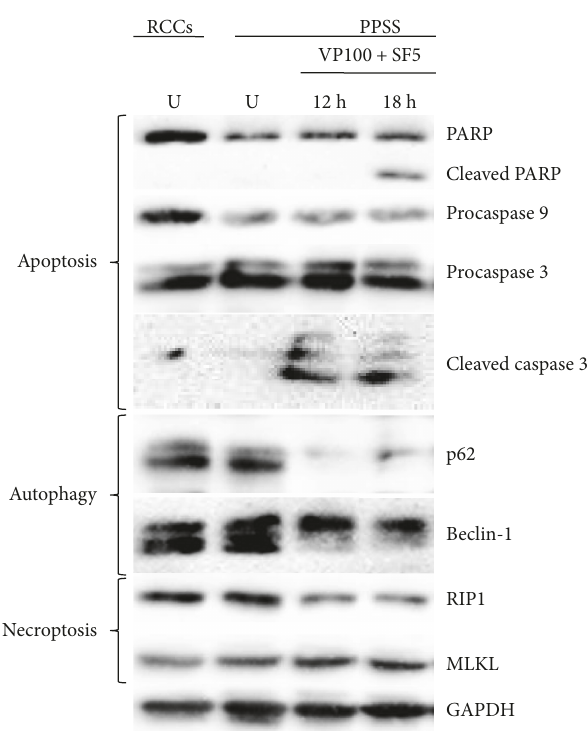
Figure 4: VP+SF modulates the expression of key protein involved in apoptosis (PARP, cleaved PARP, procaspase 9, procaspase 3, and cleaved caspase 3), autophagy (p62 and Beclin), and necroptosis (RIP1 and MLKL). Cells were grown under routine culture conditions (RCC) or under prolonged periods of serum starvation (PPSS, for 8 days). PPSS cells were treated with VP (100 μ M) +SF (5 μ M) for 12 or 18hs. Control (untreated) cells (U) were incubated with equivalent concentrations of